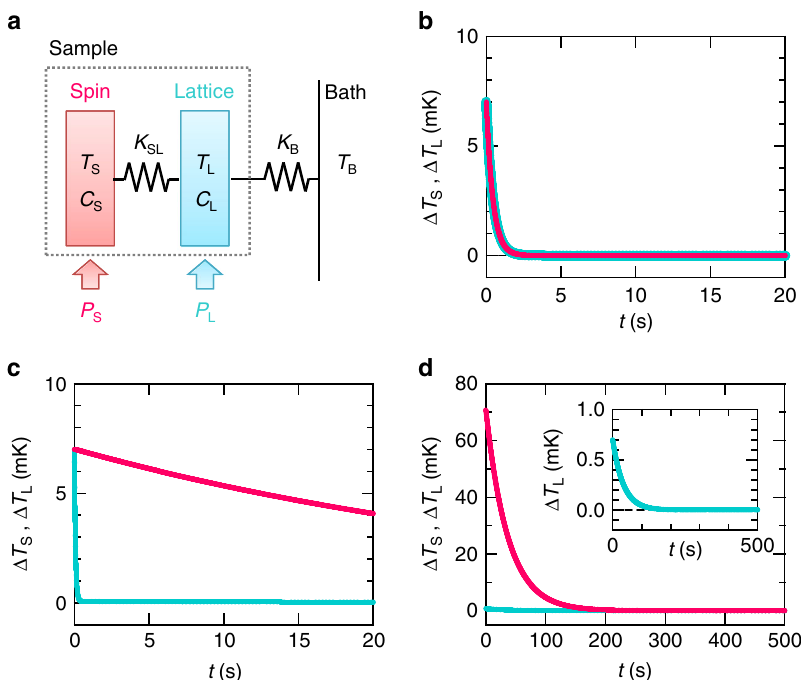
Fig. 3 Simulation results of the thermal relaxation. a Schematic diagram of the experimental situation. The heat supplied to the spin system fi rst fl ows to the lattice system through the thermal conductance, K SL , and then to the heat bath through K B . P S ( P L ) and C S ( C L ) represent the heating power of the spin (lattice) heating and the heat capacity of the spin (lattice) system, respectively. T S , T L , and T B denote the temperature of the spins, lattice, and bath, respectively. b The thermal relaxation curve when the spins are strongly coupled to the lattice [ Δ T S ( t ) = T S ( t ) − T B and Δ T L ( t ) = T L ( t ) − T B ]. The thermal relaxation curve when the spins are decoupled from the lattice for c the lattice heating and d the spin heating. Inset of d : the enlarged fi gure of the main panel. Magenta and cyan lines represent Δ T S ( t ) and Δ T L ( t ), respectively